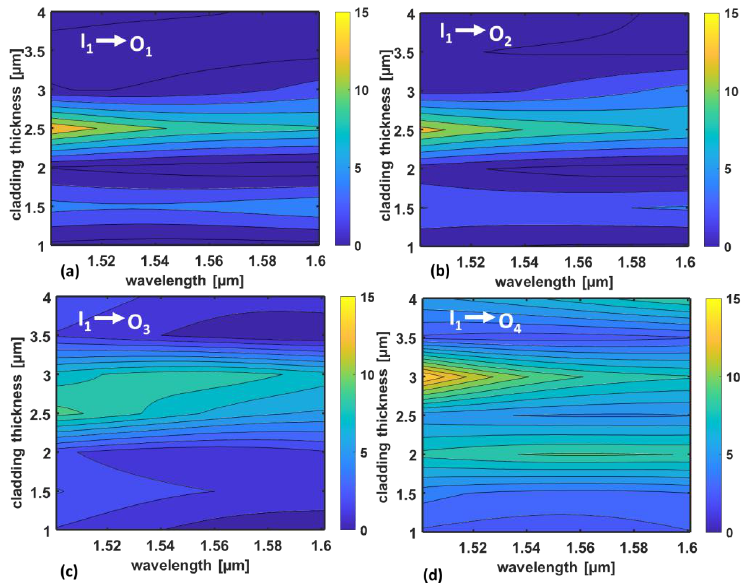
Figure 4. Insertion loss in dB, calculated as a function of the wavelength and of the cladding thick- ness, at the receiving OPAs, i.e., O 1 , O 2 , O 3 , and O 4 , when the transmitting OPA I 1 is excited: ( a ) IL 1 , ( b ) IL 2 , ( c ) IL 3 , and ( d ) IL 4 . The simulated device exploits reconfigurable OPAs made of N = seven taper antennas with a taper length L T = 2 μm. The link distance is d link = 70 μm.